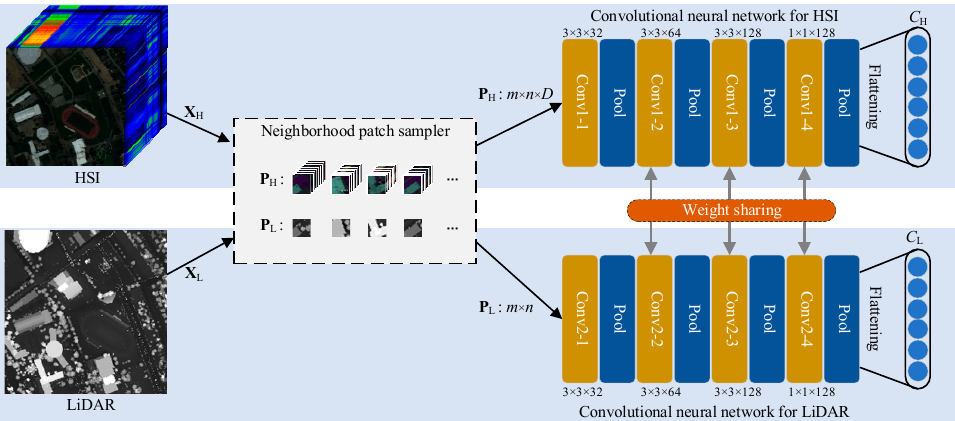
Figure 2. Illustration of the structure of CCNet. Conv and Pool denote the convolution and maximum pooling operations, respectively. p is the given neighborhood size.